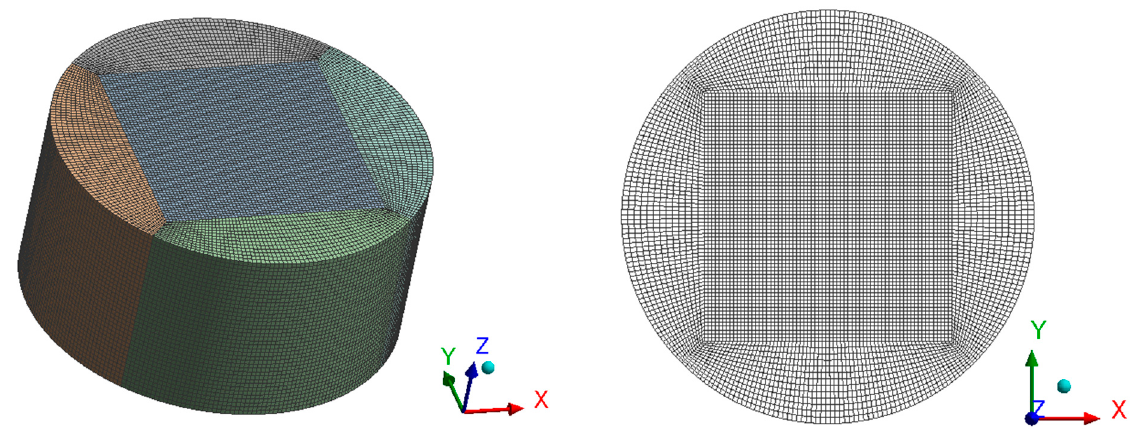
Figure 4. Computational mesh; isometric view ( left ) and wireframe top view ( right ).